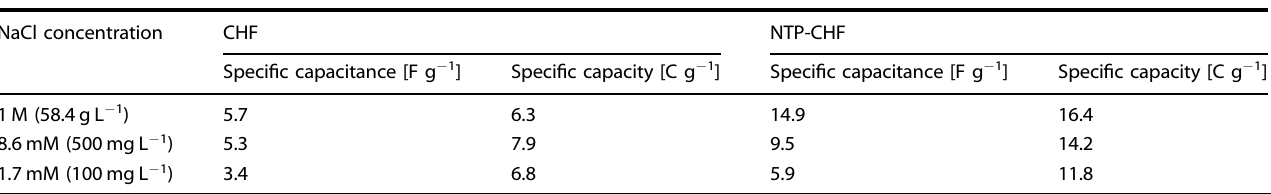
Fig. 3 Electrochemical properties of CHF and NTP-CHF. Cyclic voltammetry curves ( a ) in 1 M and 8.6 mM NaCl solutions at 5 mV s − 1 , ( b ) under various scanning rates, and c in the presence and absence of Ca 2 + , ( d ) Nyquist plots of CHF and NTP-CHF. Note that NTP-CHF was used as electrodes in ( b ) and ( c ), and all tests were performed in 1 M NaCl solution otherwise noted. Table 2. Electrochemical properties of CHF and NTP-CHF in NaCl